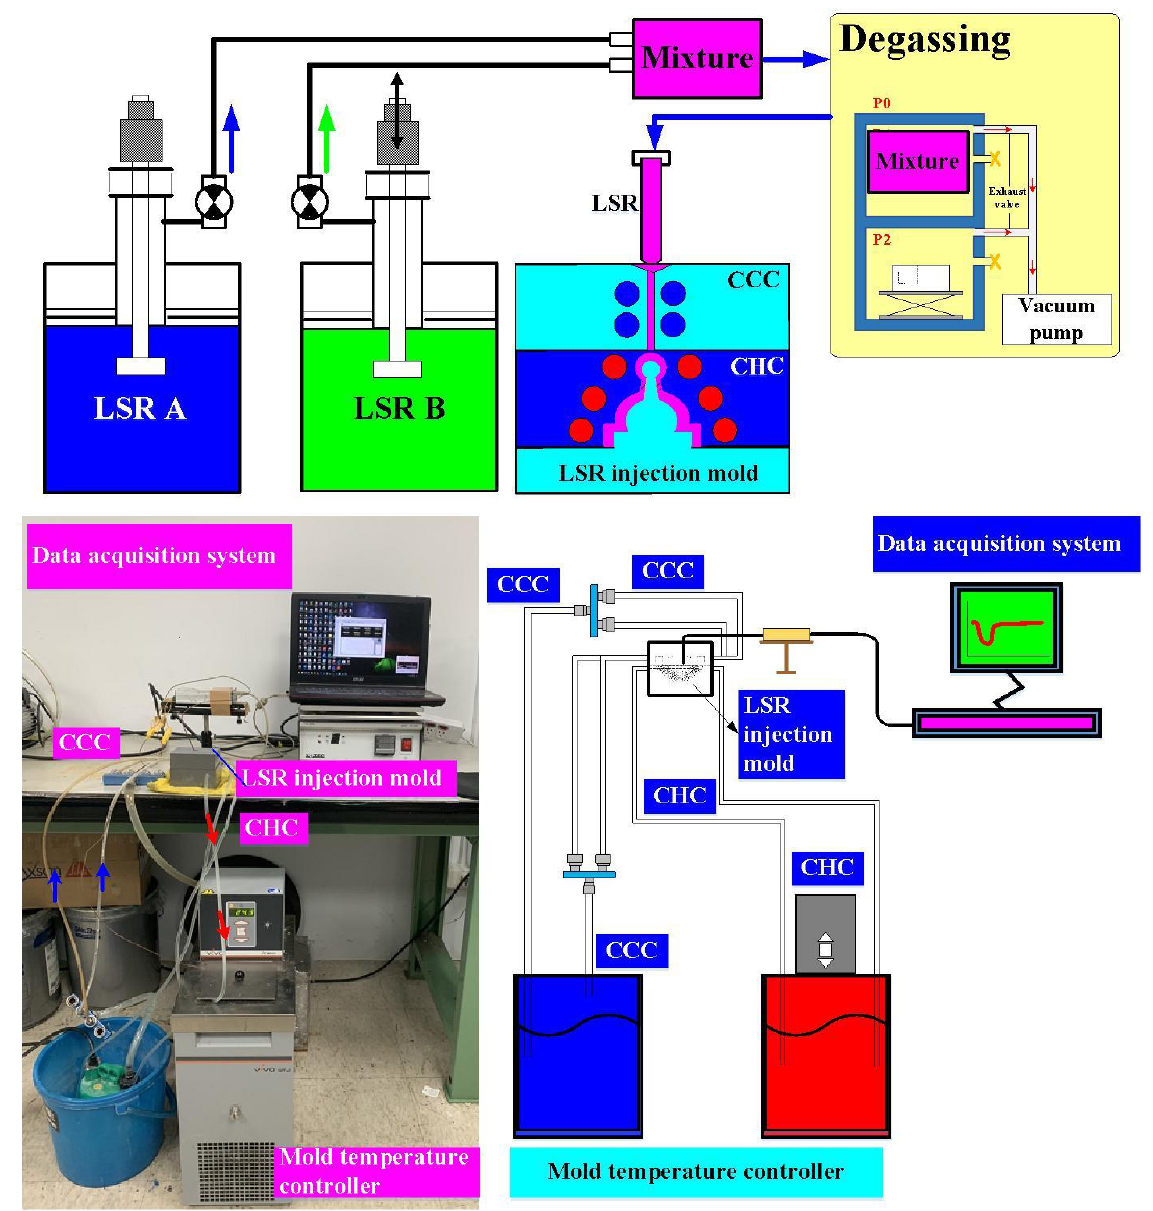
Figure 6. A rapid tool with CHC and CCC for LSR injection